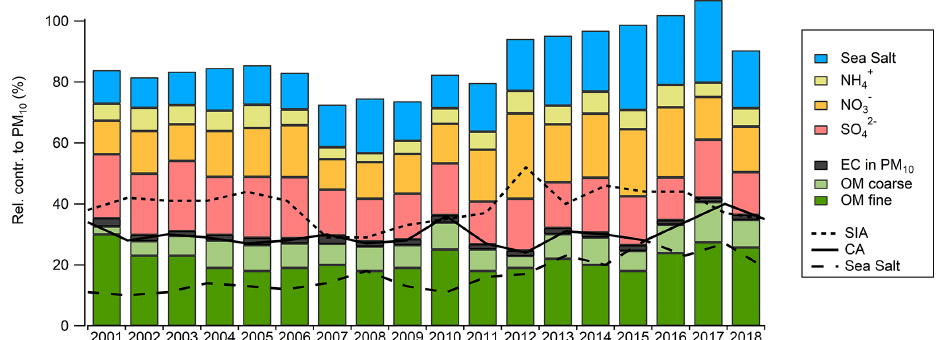
Figure 5. Mass closure of PM 10 for Birkenes for the 2001–2018 period (unit: %). Sea salt is the sum of Na + , Mg 2 + , and Cl − ; secondary inorganic aerosol (SIA) is the sum of SO 2 − OC:OM = 1.9 (Yttri et al.,